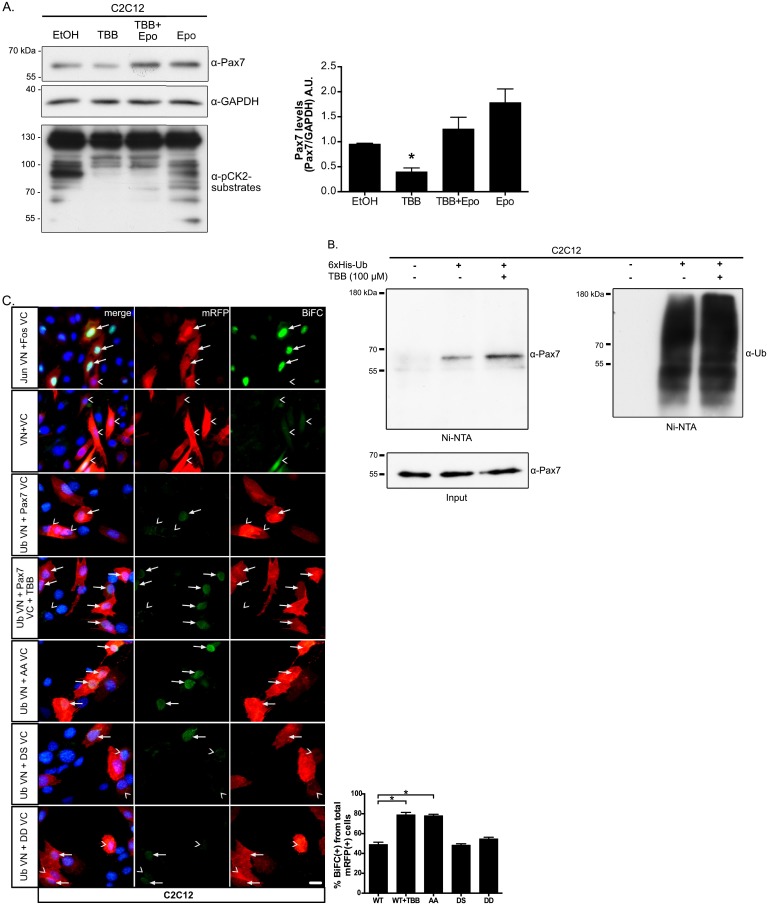
CK2 inhibition in proliferating myoblasts increases Pax7 ubiquitination and its proteasome-dependent degradation.(A) TBB-induced Pax7 decline is prevented by concomitant proteasome inhibition. Proliferating C2C12 cells were treated as indicated with TBB 125 μM and/or 1 μM of the proteasome inhibitor epoxomicin (Epo) for 6 hours and analyzed by Western blotting. GAPDH was used as loading control and anti-phospho-CK2 substrate antibody was used as a control of TBB treatment. Right panel shows quantification of protein levels (Pax7/GAPDH) normalized to control (DMSO); mean±SEM, n = 3; ANOVA, * p<0.05. (B) TBB increases Pax7 ubiquitination in proliferating myoblasts. C2C12 cells were transfected with Pax7 and myc-6xHis-ubiquitin, treated with DMSO or 100 μM TBB for 12 hours and 12.5 μM MG132 was added for the last 6 hours before cell lysis. Denaturing Ni-NTA pull-down, followed by Western Blot shows higher levels of ubiquitinated Pax7 in TBB treated cells. Inputs = 10% of cell extracts prior to Ni-NTA pull-down. (C) Disruption of Pax7 phosphorylation by CK2, increases its ubiquitination in vivo. C2C12 myoblasts were transfected with the specified constructs for bimolecular fluorescence complementation (BiFC) and treated with 25 μM MG132 and 125 μM TBB or DMSO as indicated, for 6 hours before fixation. Interaction of bFos-VC and bJun-VN was included as a positive control for BiFC. Transfection of VC and VN was used as a negative control, exhibiting non-specific diffuse fluorescence signal. Arrows indicate positive BiFC and arrowheads shows transfected cells (mRFP positive cells) without complementation. Quantification of BiFC positive cells from total mRFP positive population mean±SEM, n = 3; ANOVA, * p<0.05.